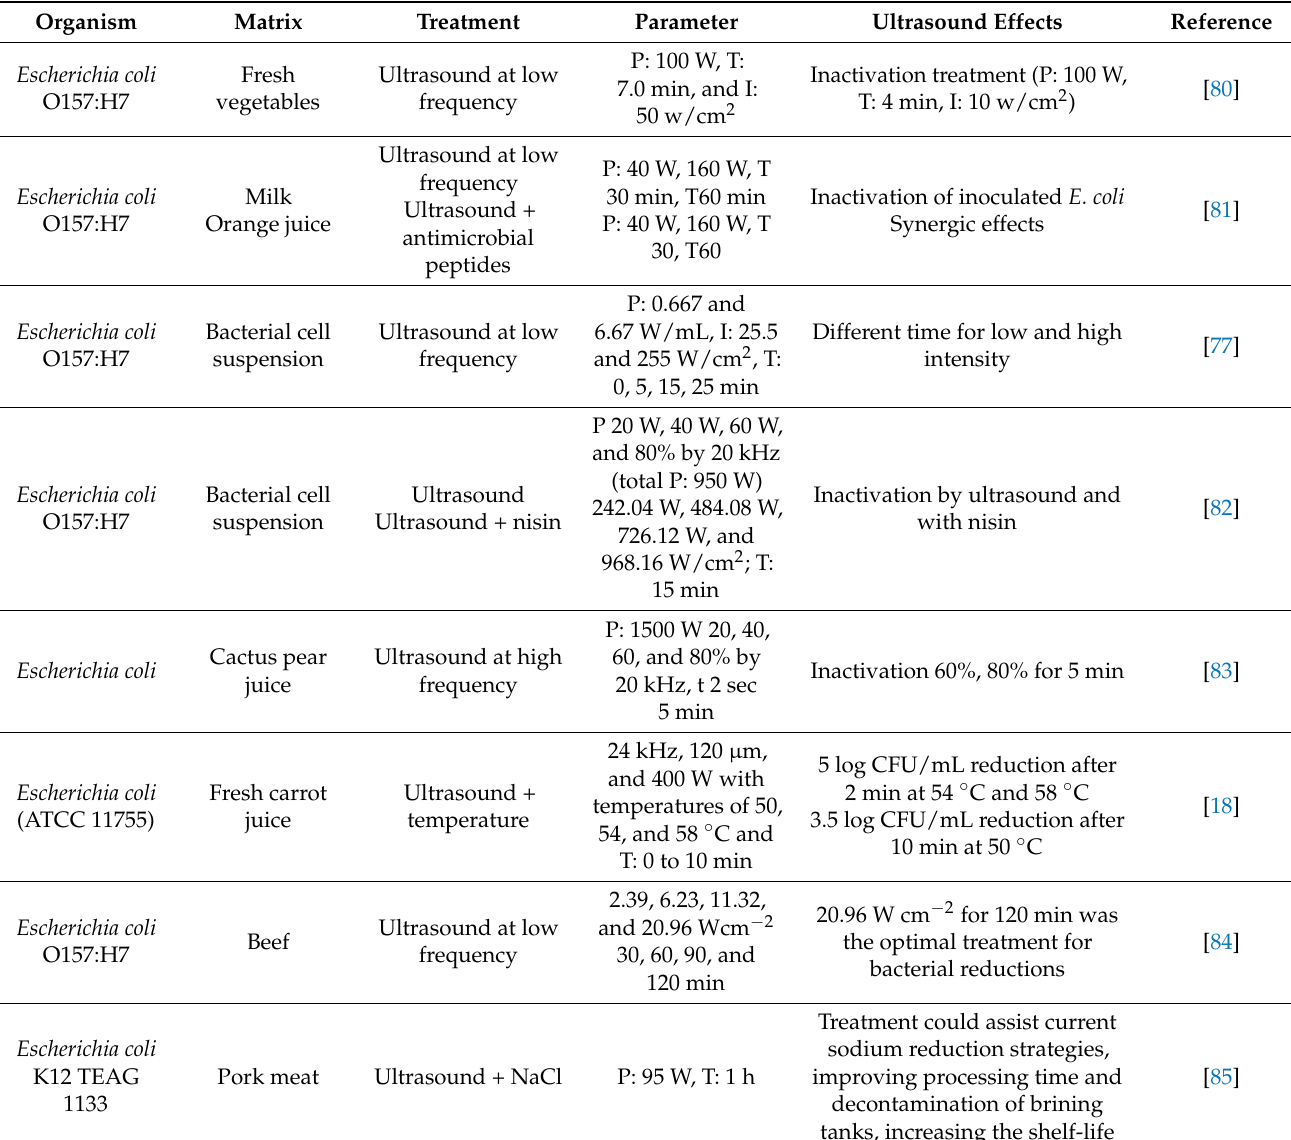
Table 2. Ultrasound effects as single or combined non-thermal technology: Escherichia coli